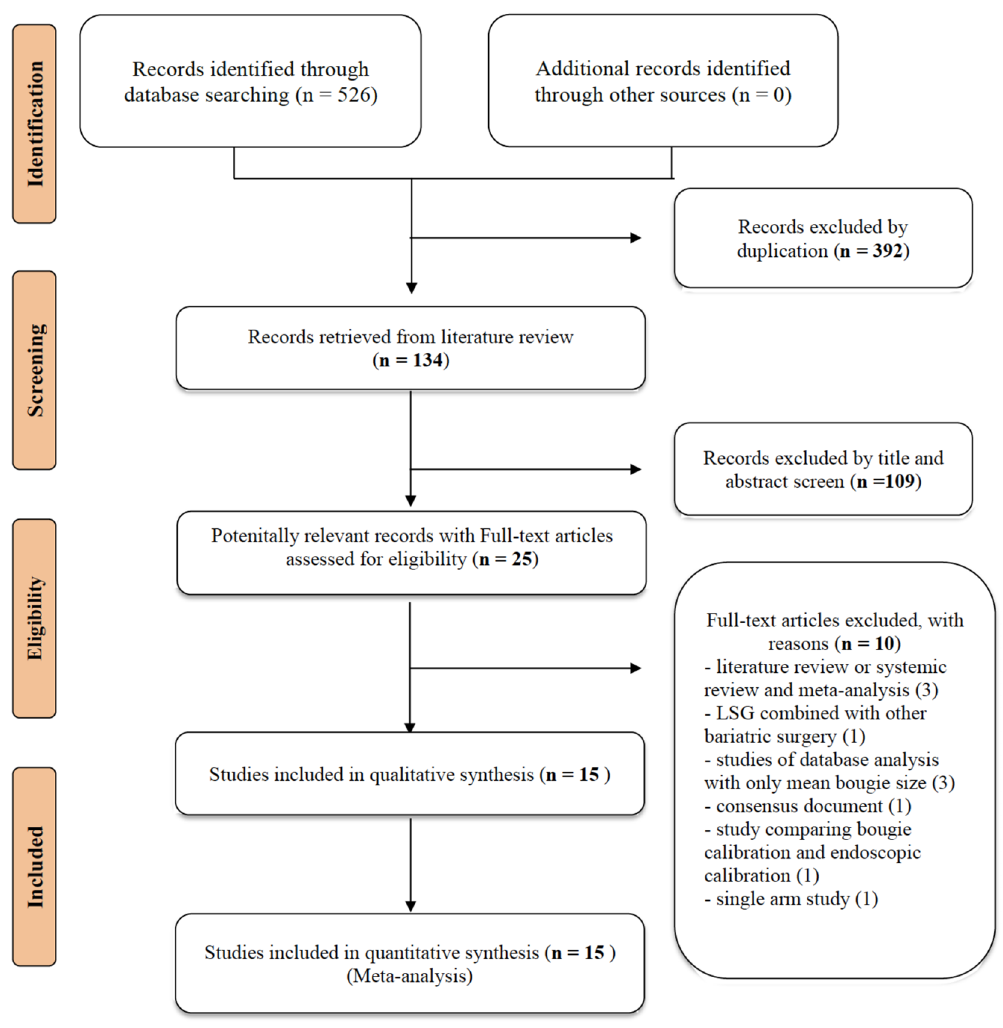
Figure 1. PRISMA flowchart. A total of 15 studies were enrolled in this network meta-analysis. The picture was created with Adobe Photoshop CC 2018 and Sketch Version 45.1